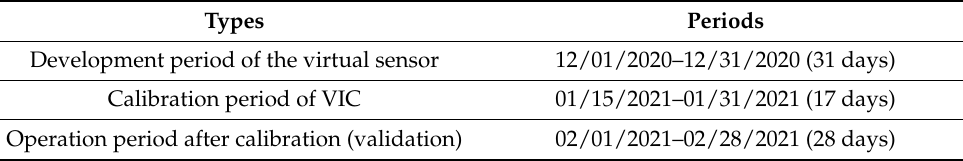
Table 2. Periods for training, testing, operation, calibration, and validation of the virtual